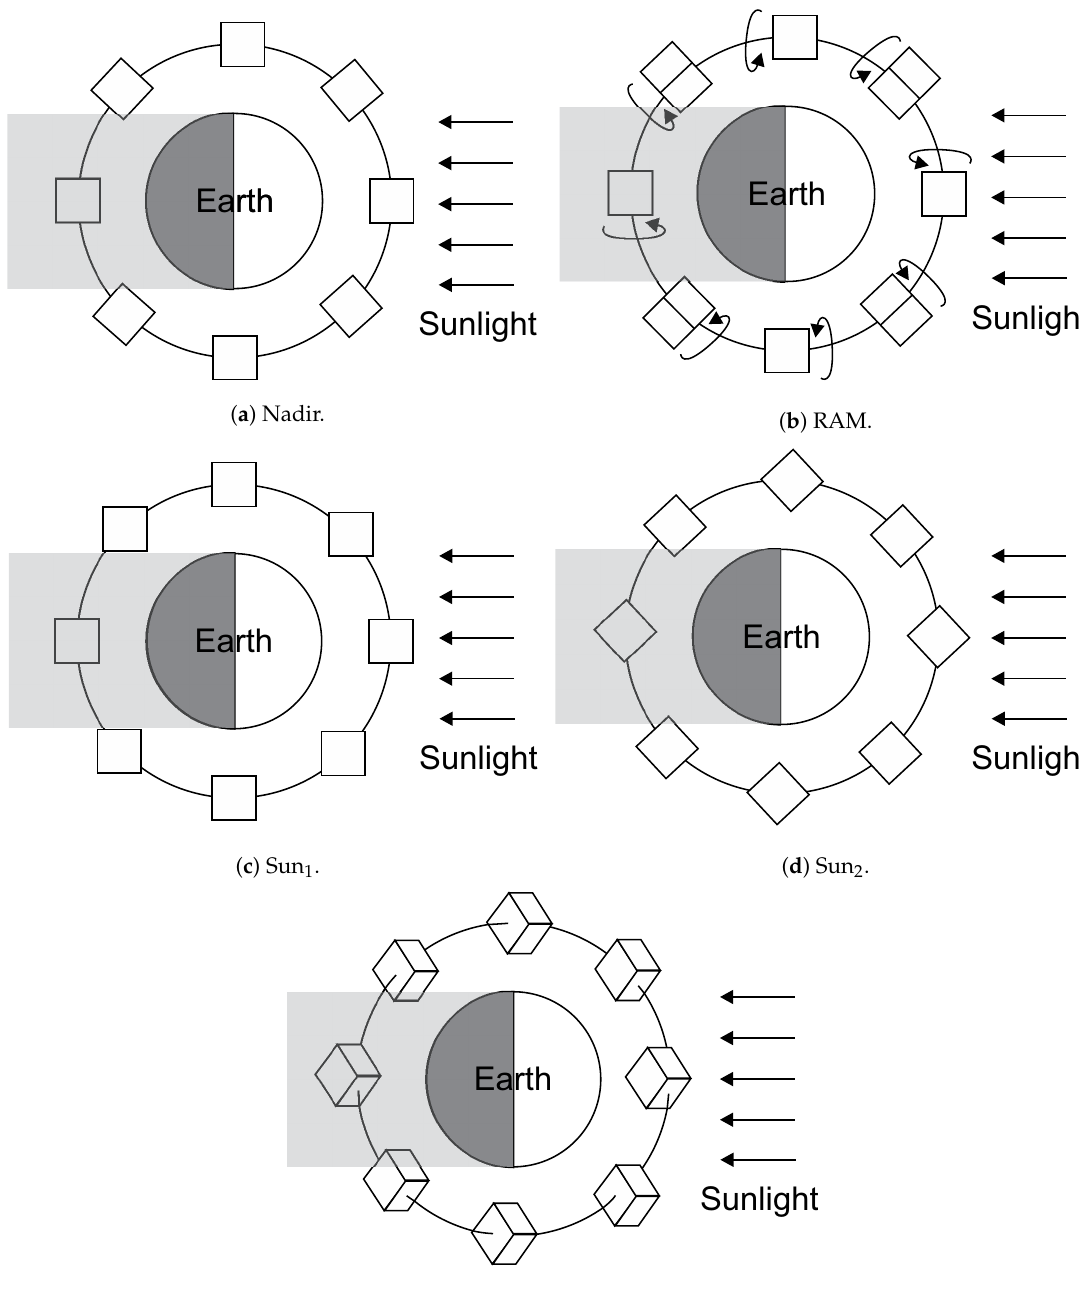
Figure 3. Attitude